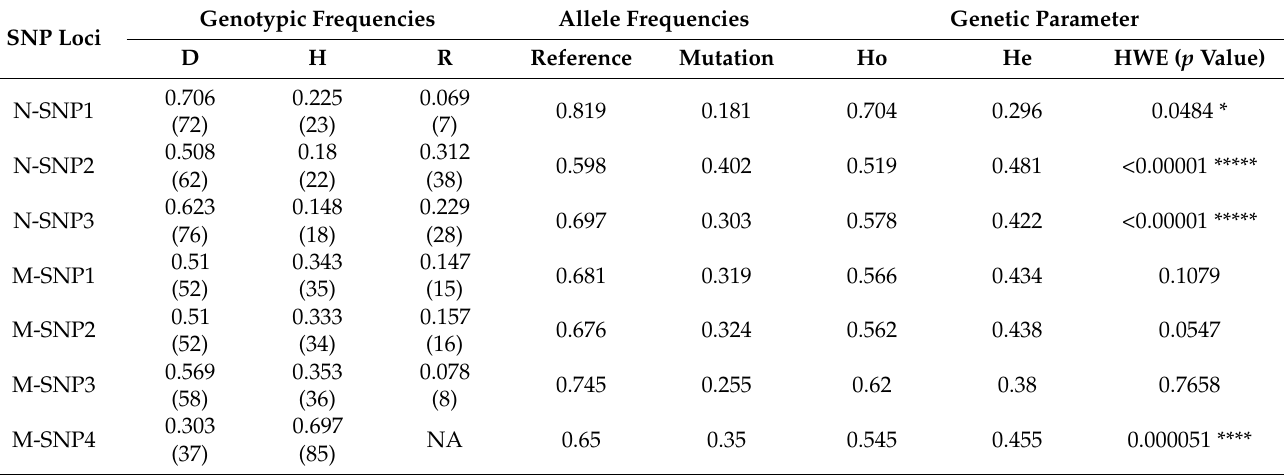
Table 2. The genetic diversity of the cow AANAT and ASMT genes.